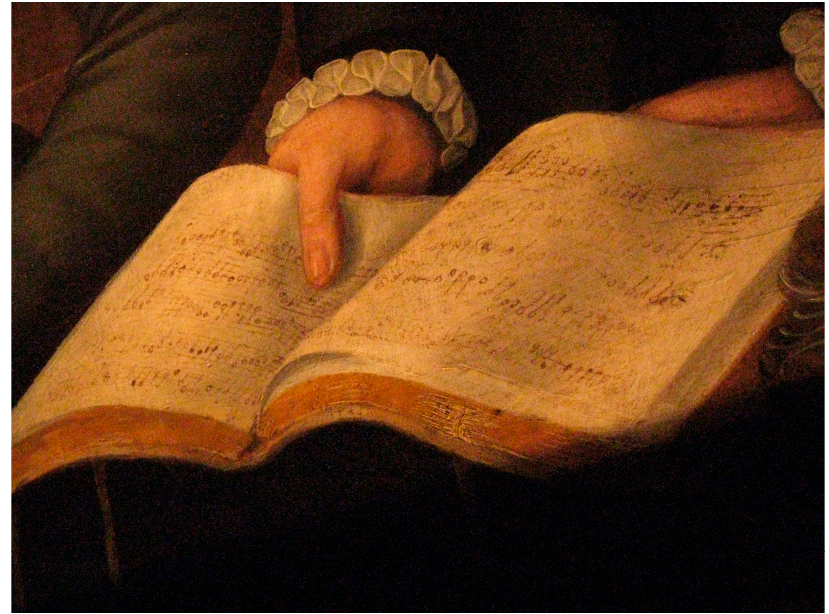
Figure 2. Detail of illegible partbook from Four Children Making Music (photograph credit: Benjamin Hebbert).